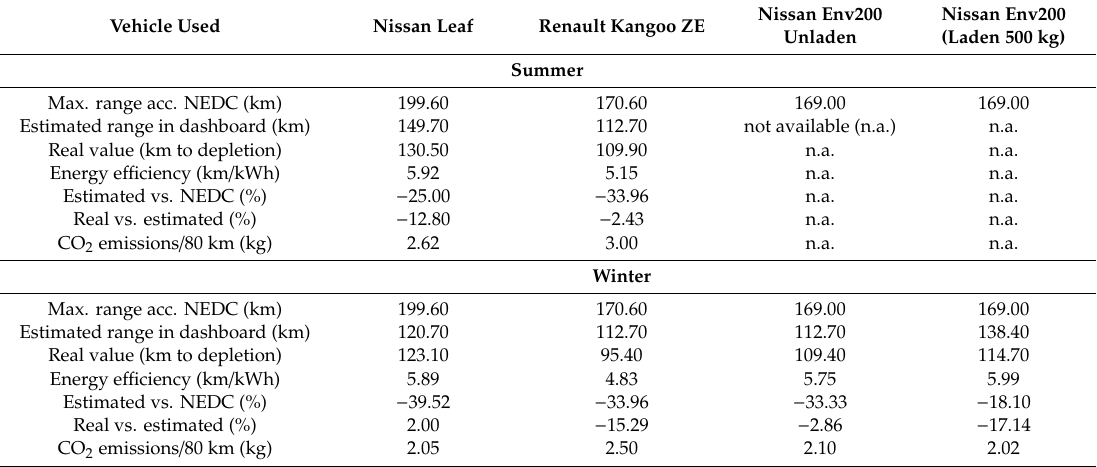
Table 4. Range comparison between NEDC values, dashboard estimations and real values. Vehicle